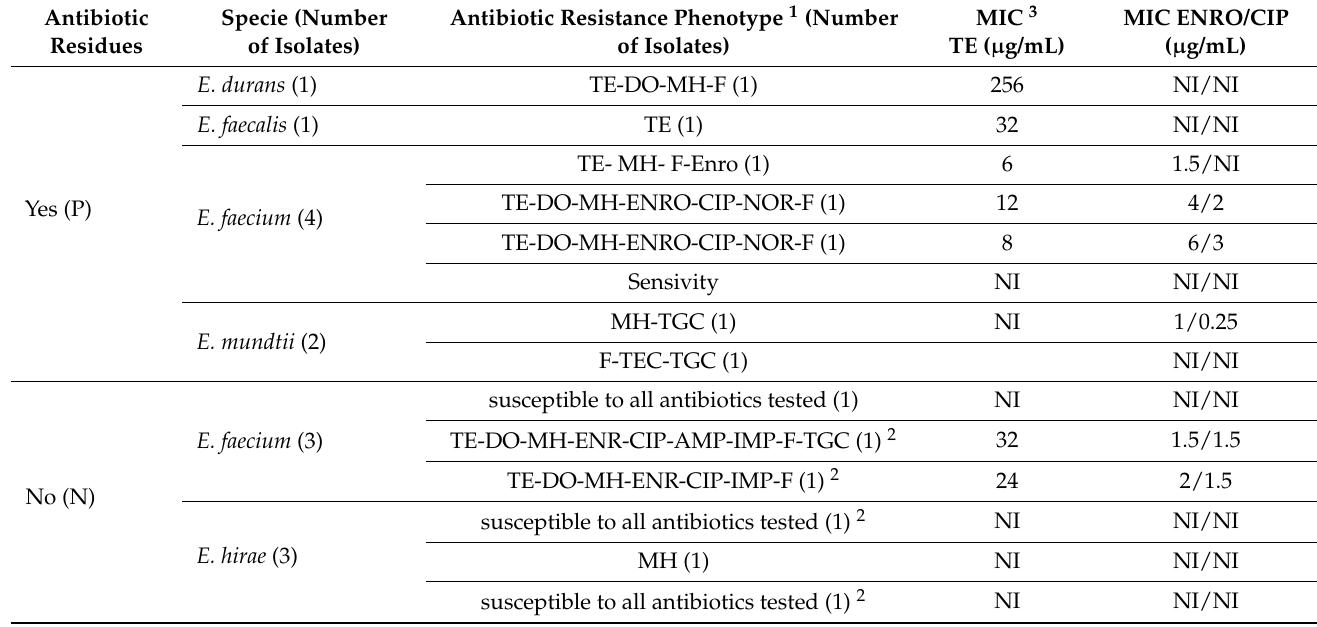
Table 7. Antimicrobial resistance phenotype of enterococci isolated from goat meat. Samples with the presence of antibiotic residues (P) and free of antibiotic residues